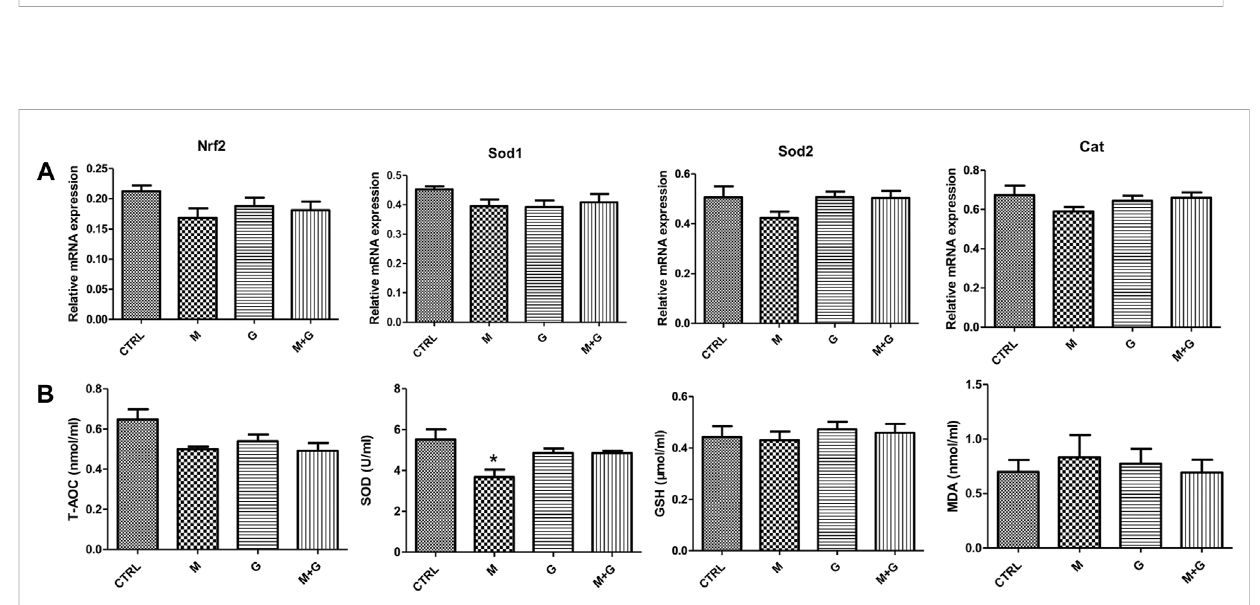
FIGURE 6 Gene expression of Nrf2, antioxidative genes and analysis of medium redox state. (A) Gene expression of Nrf2 and antioxidative genes; (B) Analysis of medium redox state. *, signi fi cantly different from CTRL at p < 0.05.